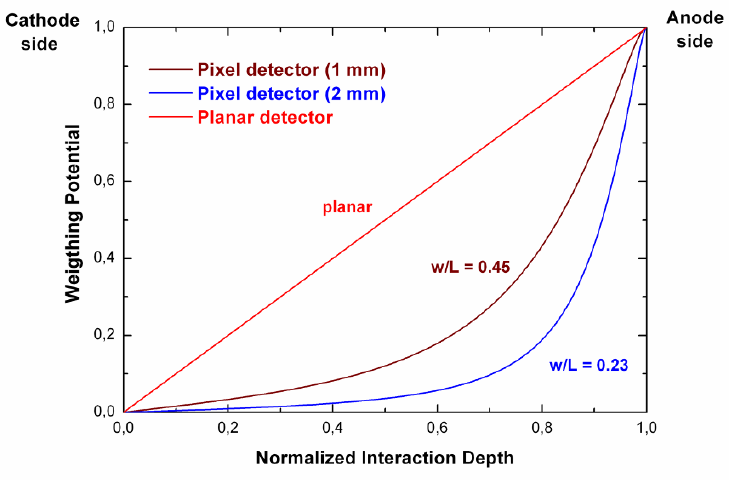
Figure 18. The weighting potential for pixel detectors and a planar detector as a function of the normalized interaction depth (interaction depth/detector thickness); the w/L parameter is the ratio between the pixel size and the detector thickness. The weighting potential and then the detector signals are more unipolar as the w/L ratio decreases, in agreement with the small pixel